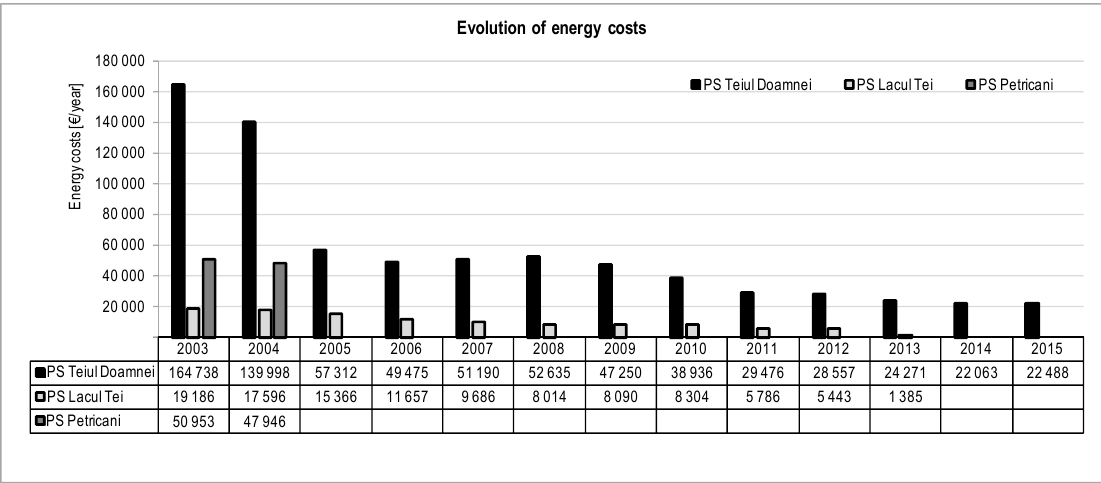
Figure 7. Evolution of energy costs for the booster stations in Tei-Colentina